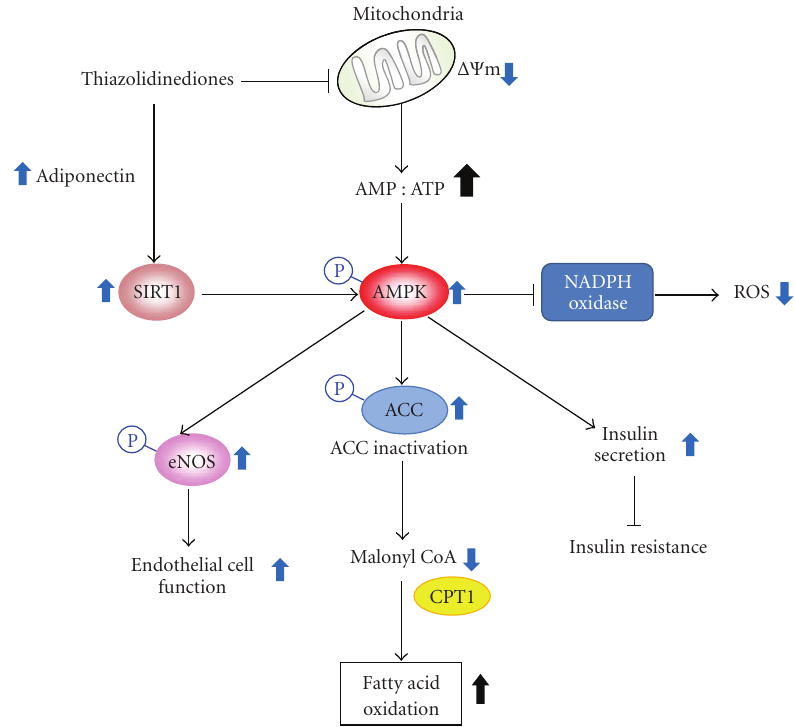
Figure 5: The e ff ects of PPAR γ activators on AMPK-dependent functions. ACC: acetyl-CoA carboxylase; CPT1: carnitine palmitoyltrans- ferase 1; ROS: reactive oxygen species; SIRT1: sirtuin; ΔΨ m: change in mitochondria membrane